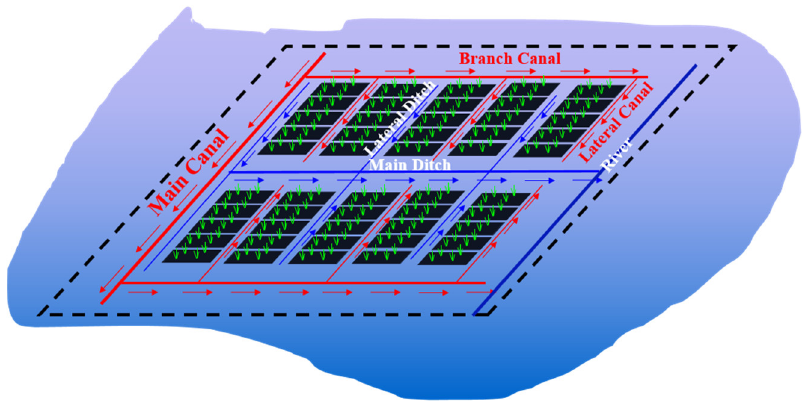
Figure 2. Irrigation channel and drainage ditch system of the rice irrigation district.